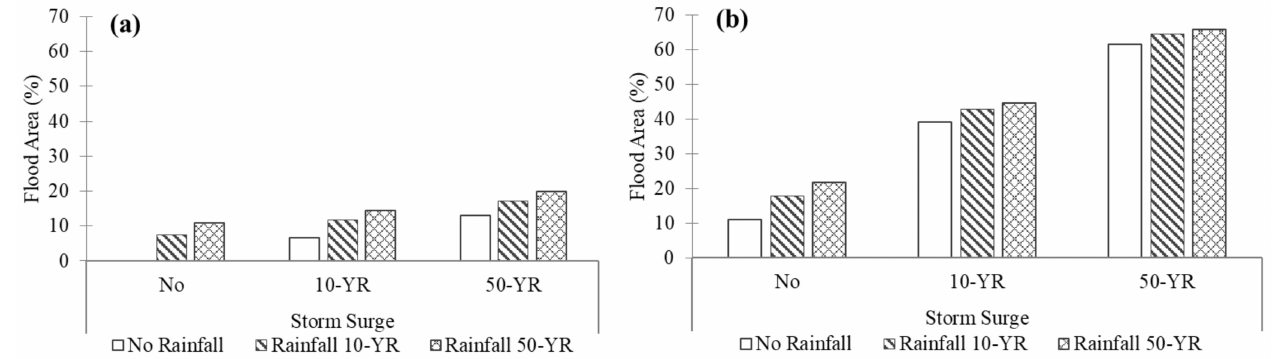
Figure 13. Percentage of total flood extent (flood depth > 0.3 m) for ( a ) 2020 and ( b ) 2070 under a high SLR scenario and RCP8.5 climate change scenario.